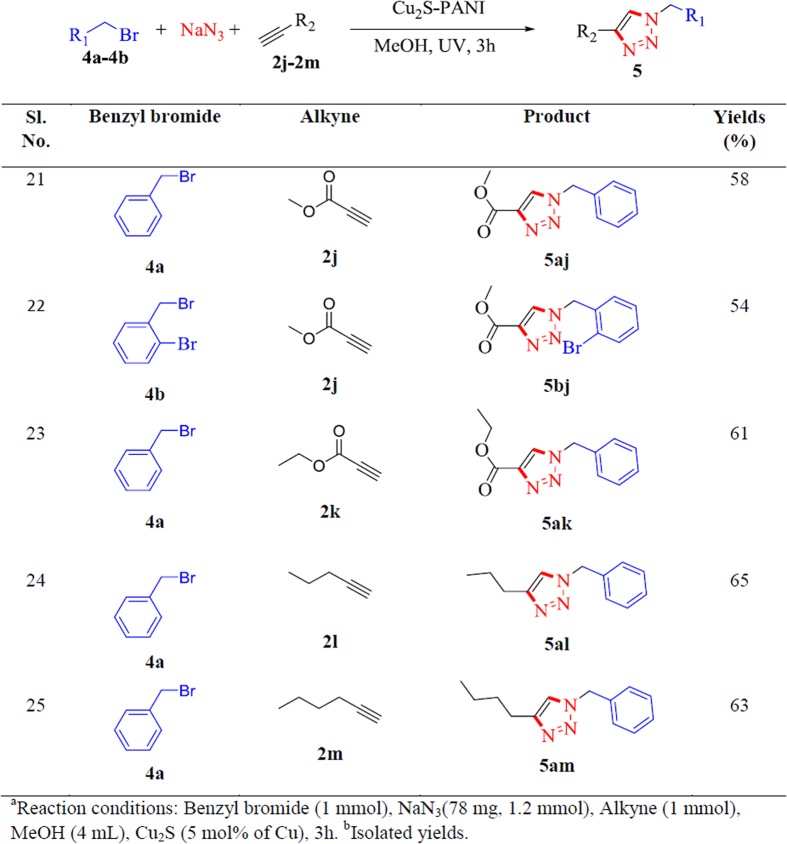
Substrate scope for multicomponent click products under UV irradiationa,b.